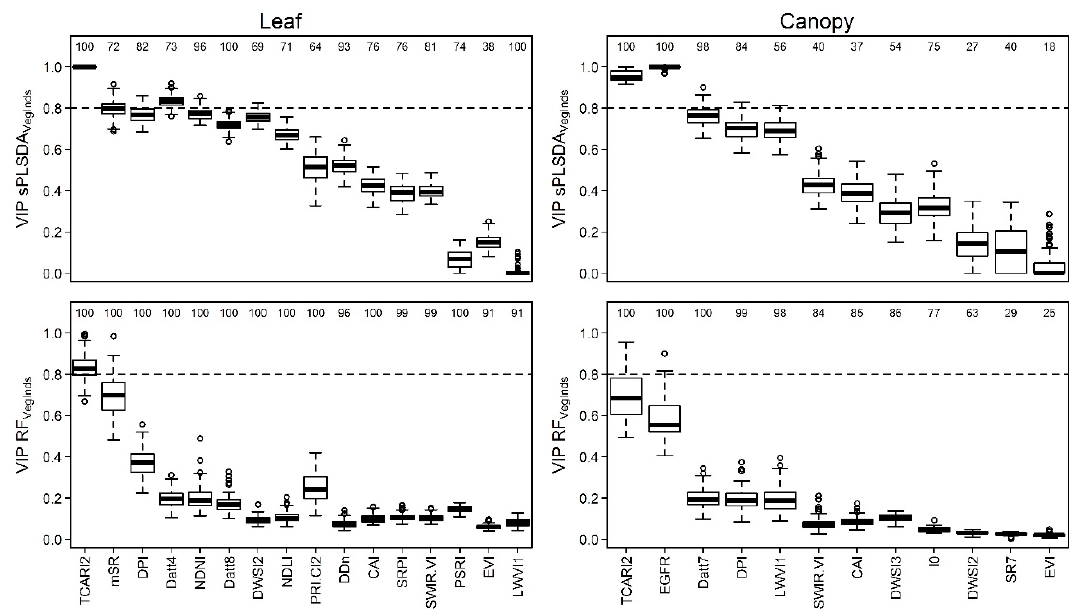
Figure 4. Distribution of Variable Importance (VIP) values of vegetation indices from 100 iterations of classification models of Acacia longifolia using field spectra of leaves and canopies. VIP values higher than 0.8 (dashed lines) indicate highly important predictors. For explanations of vegetation indices, see Table 3. Numbers above boxes show the frequency with which the respective index was selected in the final model (max = 100). Boxplots: show medians, interquartile ranges and extreme values within 1.5 × interquartile range.